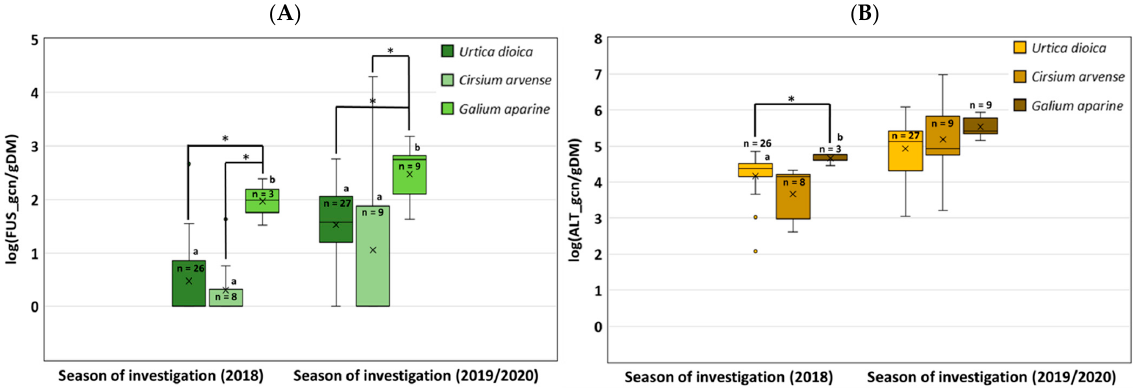
Figure 5. Abundance of Fusarium ( A ) and Alternaria ( B ) fungi expressed as LOG (x + 1) (gene copy numbers) of Fusarium (FUS_gcn/gDM) and Alternaria (ALT_gcn/gDM) on Urtica dioica , Cirsium arvense and Galium aparine in 2018 and 2019/2020. The different weed plants were sampled at the edges of all kettle holes investigated. The midline of the boxplots represents the median; x is the mean value; the upper and lower limits of the boxes are the third and first quartiles. Asterisk brackets indicate significant differences between parameters investigated (* p -values < 0.05). a and b highlight that there is a significant difference ( p < 0.05) between the samples to be